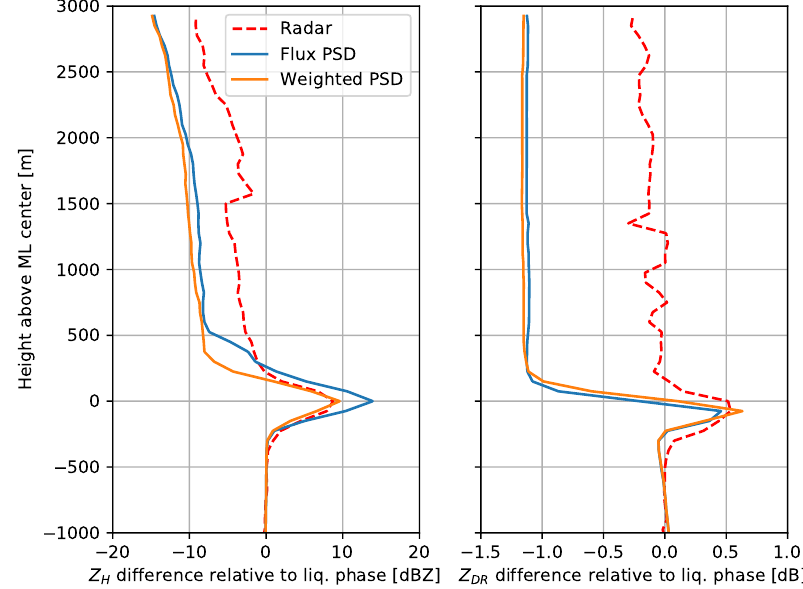
Figure 8. Average vertical observed and simulated (with the flux-based and weighted approaches) profiles of Z H and Z DR . The x -axis corresponds to the average shift with respect to the average values in the liquid phase below the ML. The y -axis corresponds to the distance with respect to the peak of the bright-band.